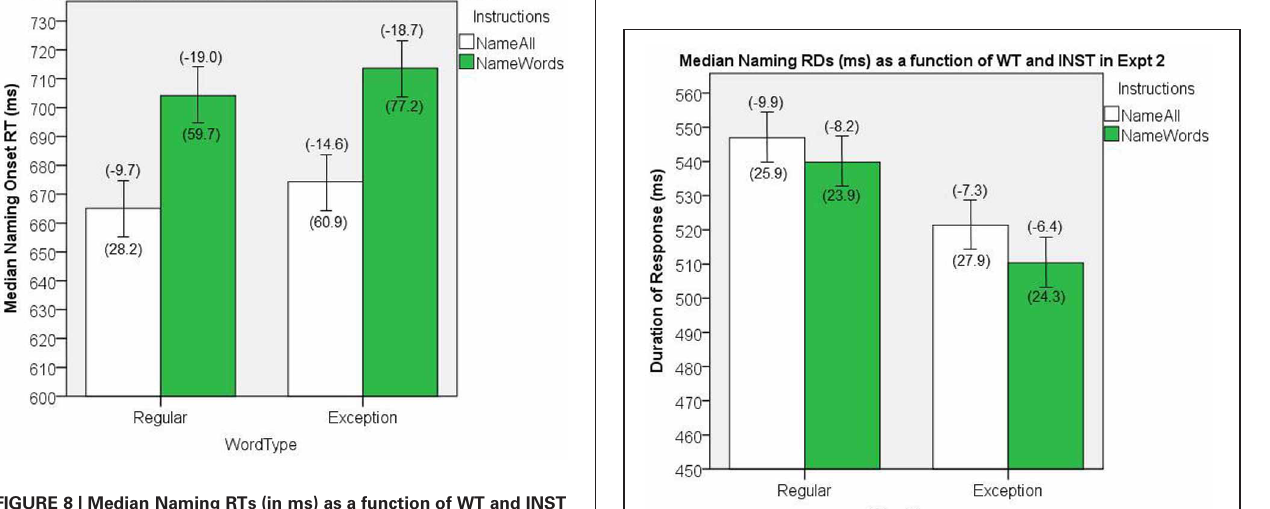
FIGURE 8 | Median Naming RTs (in ms) as a function of WT and INST in Experiment 2. The 95% C.I.s are presented as error bars using Loftus and Masson’s (1994) method. Co-efficients relating WF to RT (ms/log FIGURE 9 | Mean ProportionAccurate as a function of WT and INST in